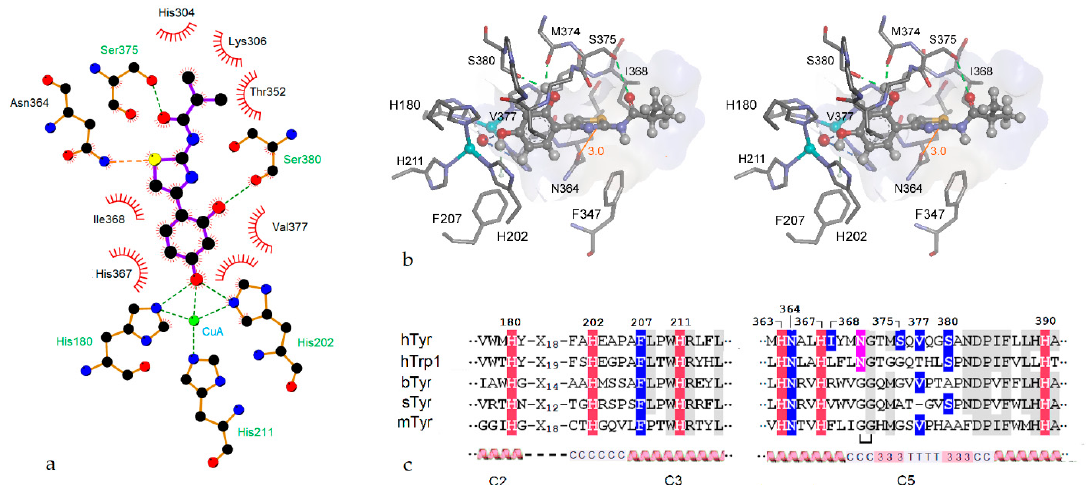
Figure 4. Virtual docking results for compound W630. ( a ) Interactions stabilizing the pose shown as LigPlot [34] diagram; ( b ) Stereo representation of the lowest-energy docking solution. Only amino acid residues directly interacting with the bound inhibitor are shown (residue numbering includes the signal peptide). The di-copper center with the bridging oxygen is visible on the left with copper ions depicted as cyan balls. The ligand is shown in ball-and-stick representation, amino acid residues as sticks. The inner surface of the binding cavity is colored according to hydrophobicity on a scale from blue for hydrophilic to brown for hydrophobic; ( c ) Partial alignments of the CuA (left) and CuB sites (right) of several tyrosinases or tyrosinase related proteins. Copper-chelating histidines are highlighted in red, residues in contact with the bound ligand in blue, and the glycosylation site N371 in pink. Amino acids conserved in at least 4 sequences are shaded gray. Secondary structure elements and core regions (see text) are shown on the bottom. hTyr—human tyrosinase; hTrp1—human tyrosinase-related protein; bTyr— Bacillus megaterium tyrosinase; sTyr— Streptomyces castaneoglobisporus tyrosinase; mTyr—mushroom ( Agaricus bisporus ) tyrosinase. The bracket below the mTyr sequences denotes an extra loop.